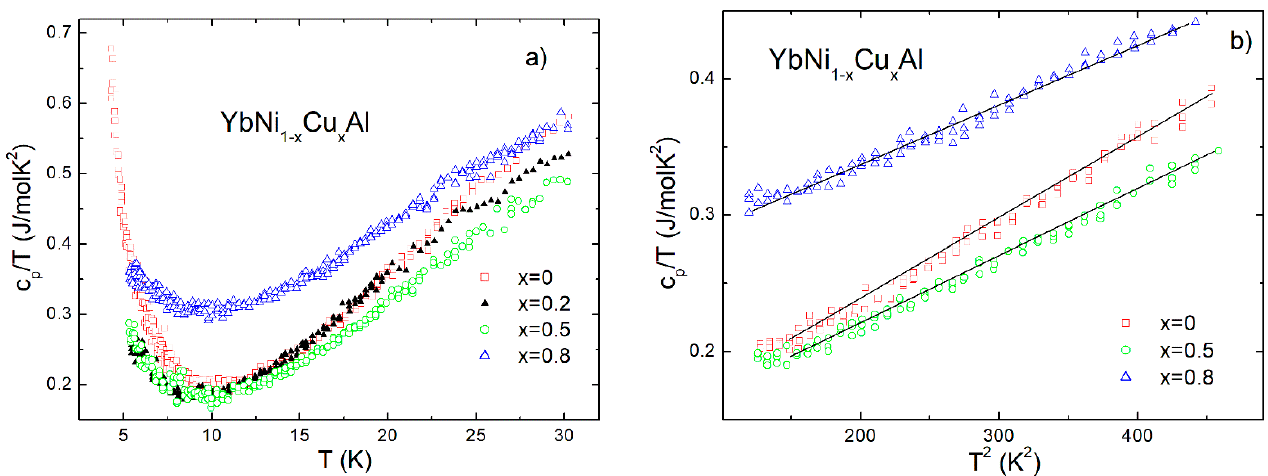
Figure 6. ( a ) c p /T vs. temperature dependence in the YbNi 1 − x Cu x Al series of alloys. The onset of competition between magnetic correlations and the Kondo effect below the minimum around 10 K is observed. ( b ) Plot of c p /T vs. T 2 dependence showing a linear behavior in the temperature range between 11 K and 20 K.